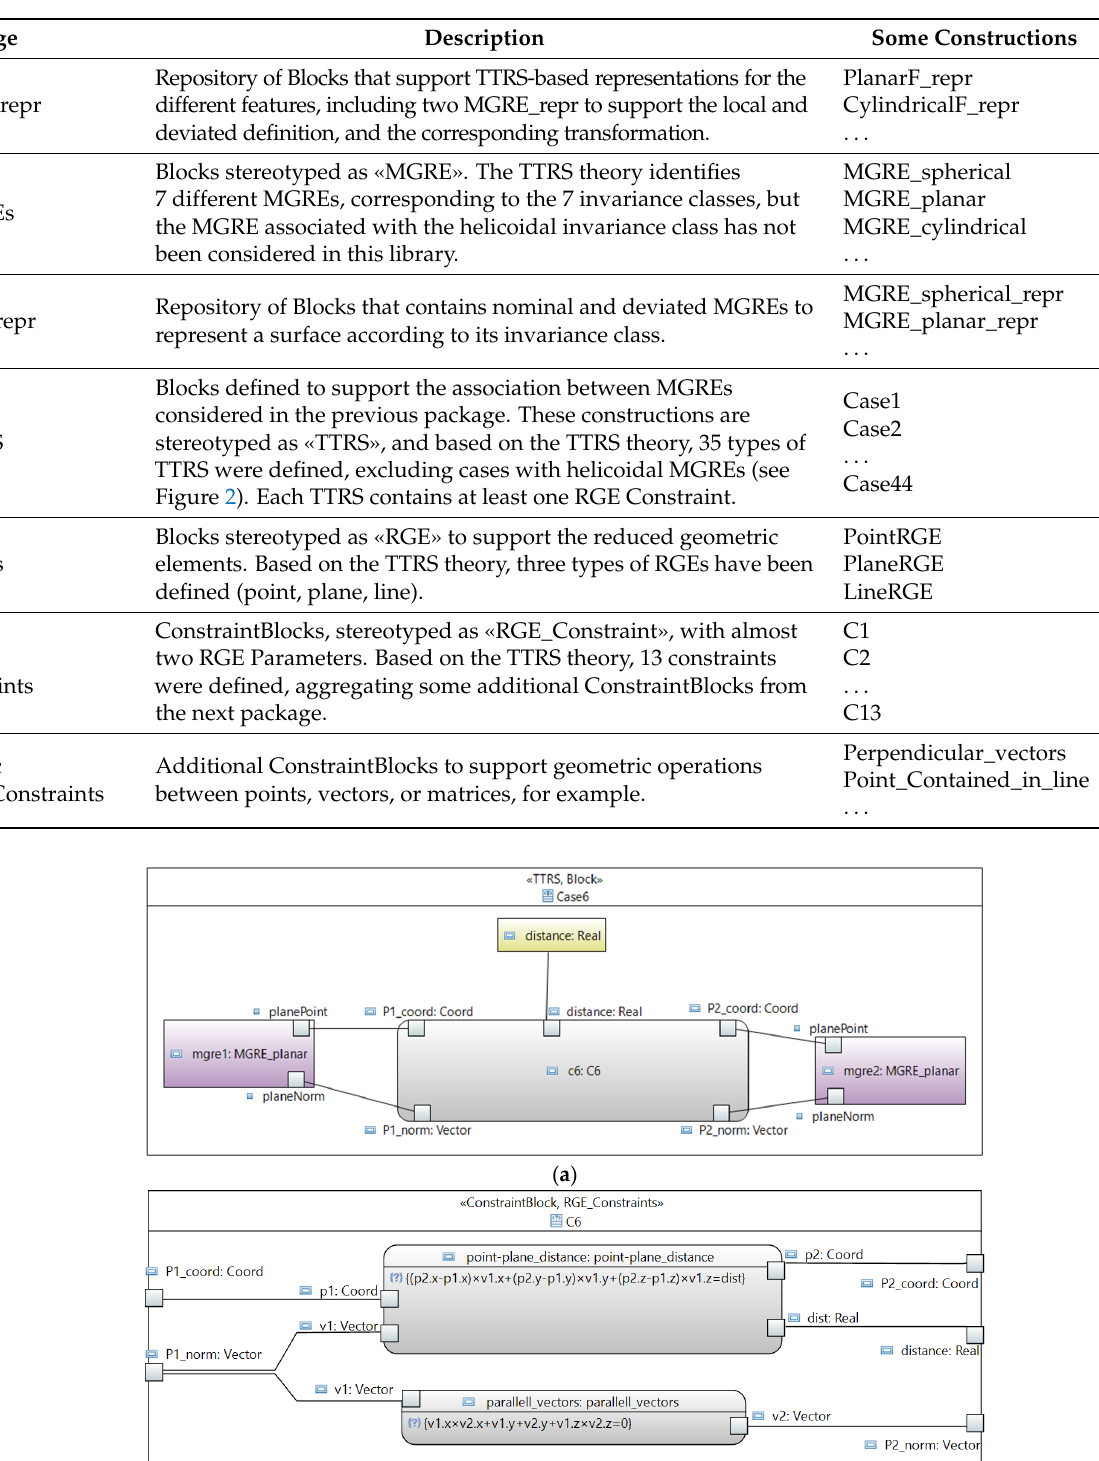
Table 2. TTRS_MLP sub-packages and contents.